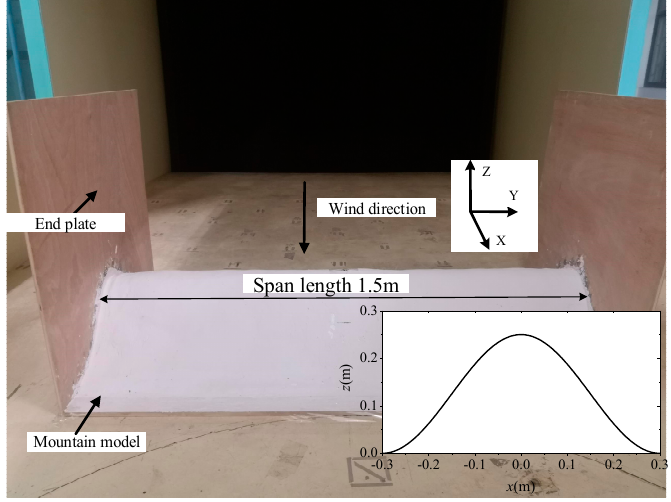
Figure 2. The hill model.